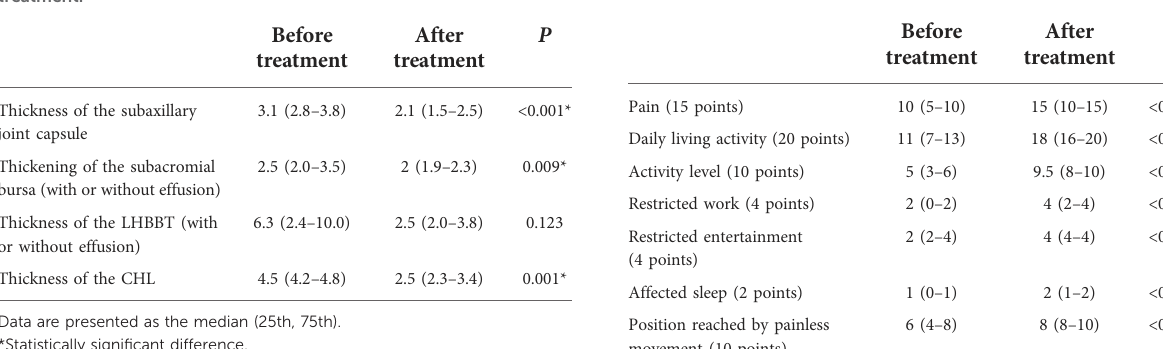
TABLE 1 Comparison of the US evaluation results before and after treatment.